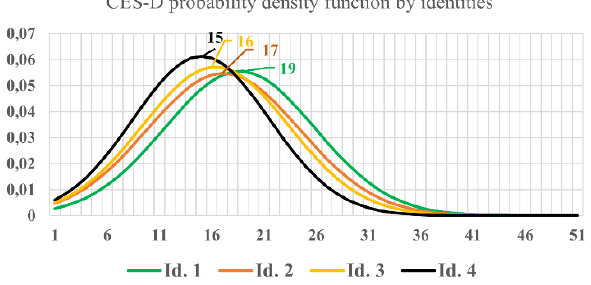
Figure 6 : Probability density function by identity